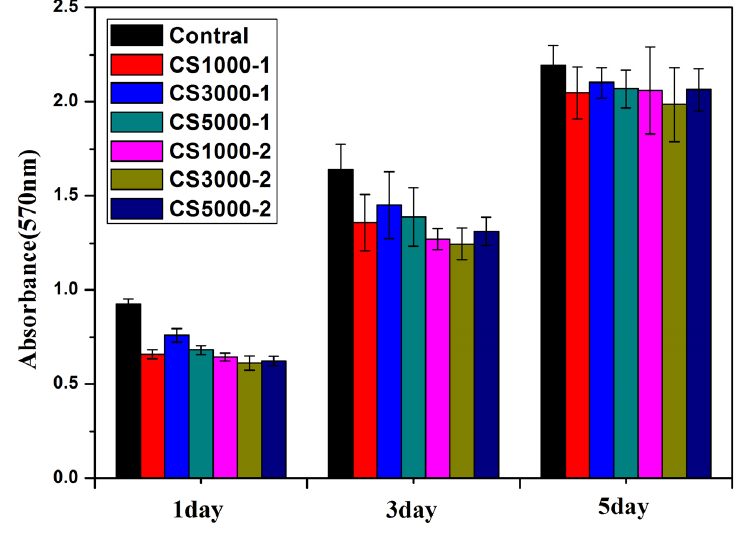
Figure 5. In vitro cytotoxicity of MG-63 cell lines after culturing with HA samples.